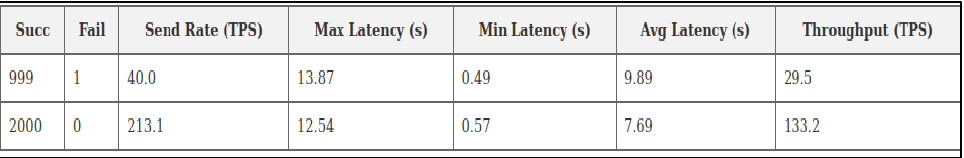
Figure 18. Caliper results for experiment 2.